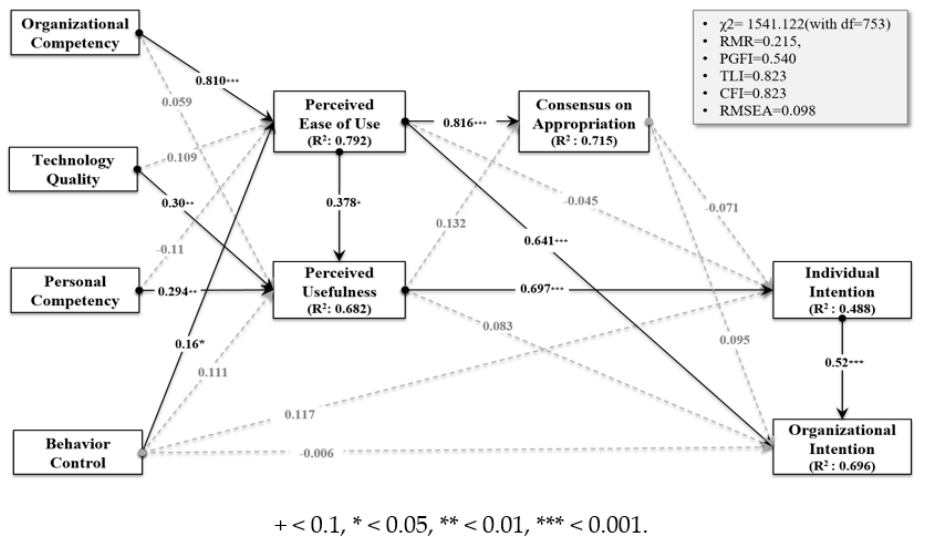
Figure 2. Results of hypothesis testing. Table 1. a ( γ = 0.810) and H4a ( γ = 0.16) are supported. This implies that increased OC and BC is